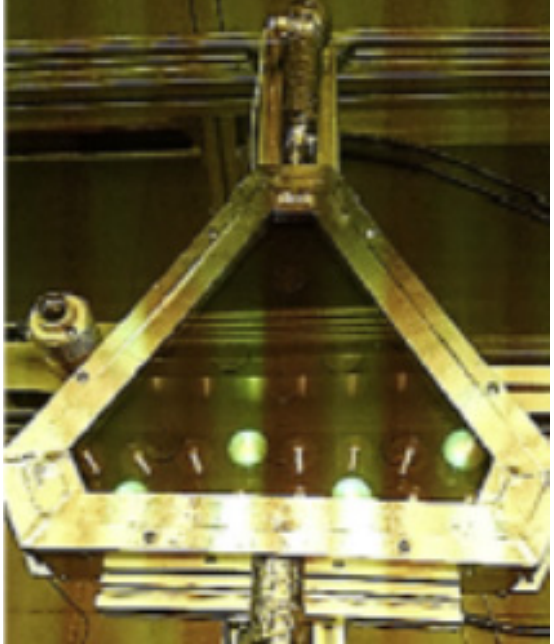
Figure 21. The novel, triangular-shaped flat-plate solar collector. Adapted with permission from ref. [158] 2019 Visa et al.